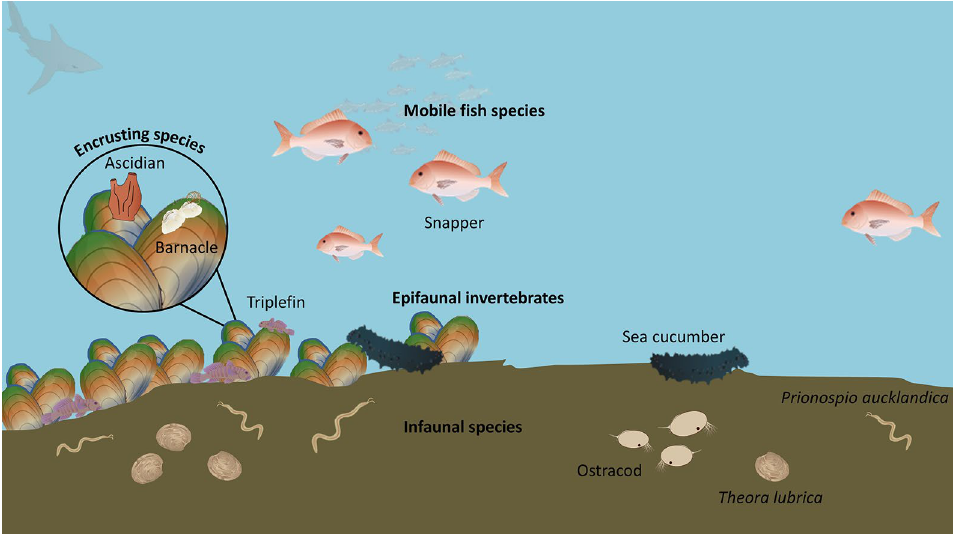
Figure 2. Conceptual diagram illustrating effects of subtidal mussel restoration on biological communities, differentiated by scales of mobility. Mobile communities of triplefins and commercially important fish species such as snapper ( Chrysophrys auratus ) are found in higher abundances on mussel beds than soft-sediment control sites, while highly transient elasmobranchs were not found to significantly differ with habitat type. Species richness and abundance of epifaunal invertebrates and encrusting species significantly increase with additional organic matter and hard substrate provided by mussels. Location-dependent changes in macrofaunal assemblage structure result from restoration efforts, with bivalve and polychaete detritovores more abundant beneath muddy, organically enriched mussel beds. Some symbols adapted from Integration and Application Network (ian.umces.edu/media-library).